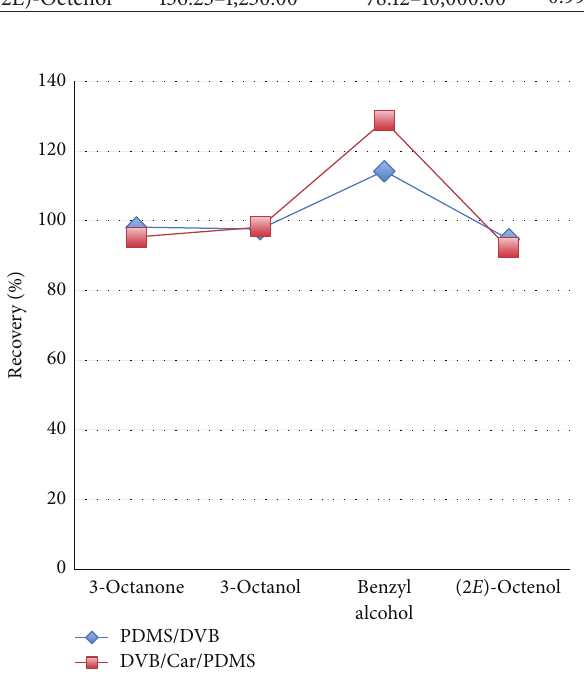
Figure 2: Comparison of the recoveries obtained with the SPME fiber coatings DVB/Car/PDMS and